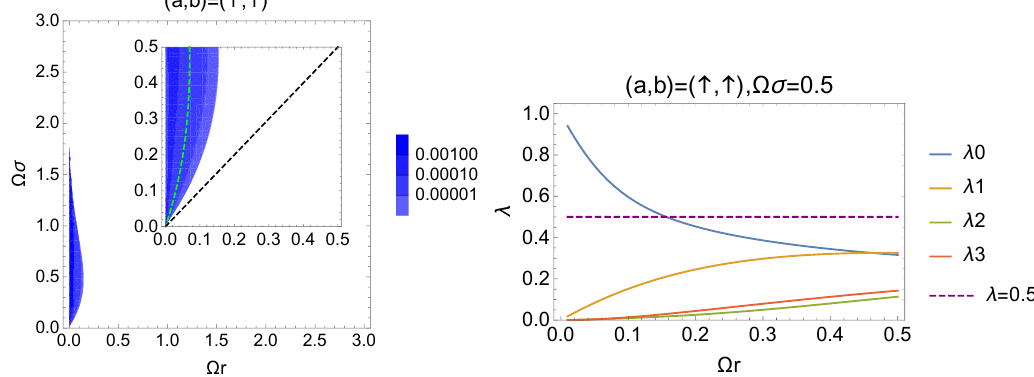
Figure 7. ( left ): The contour plot of the negativity with the initial condition |↑ A ↑ B (cid:105) . The inset is the enlarged version of the contour plot. The green dotted line represents β = 1. N (cid:54) = 0 region does not extend to the region r > σ . ( right ): The behavior of the spectrum { λ µ } of the Bell diagonal state with fixed Ω σ = 0.5 and g 0 = 10 − 2 . The eigenvalue λ 0 is dominant due to the exchange of the scalar particle.